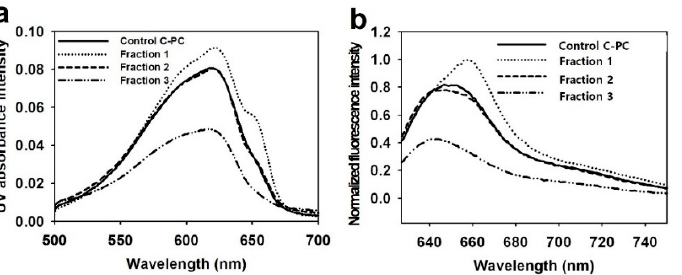
Figure 2. UV and fluorescence scanning of gel-purified phycobiliproteins according to its size ; ( a ) UV absorbance spectrum of C-Pc from 500 nm to 700 nm; ( b ) Normalized fluorescence spectrum at 609 nm for excitation.